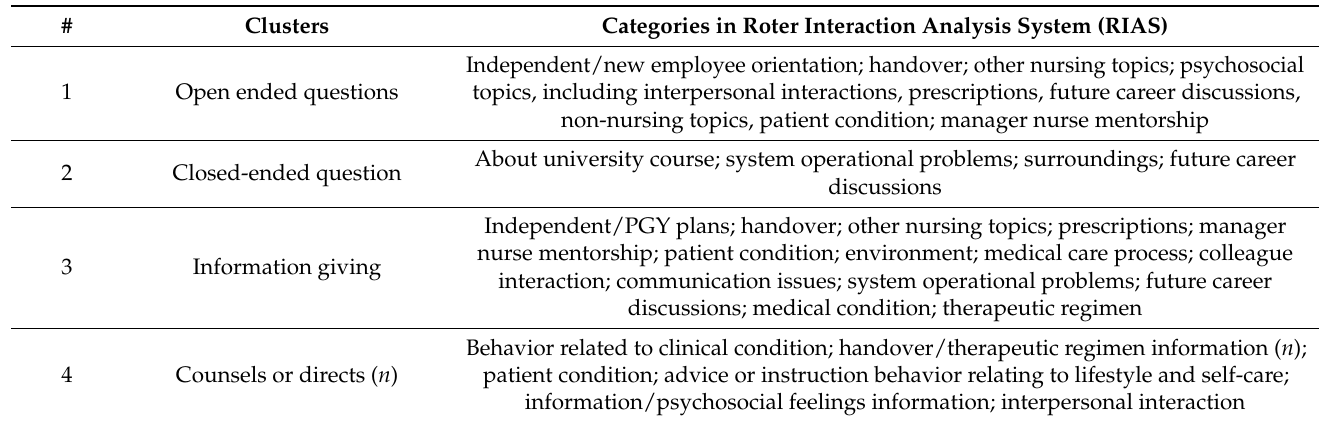
Table 1. Communication clusters and categories for senior and novice nurses’